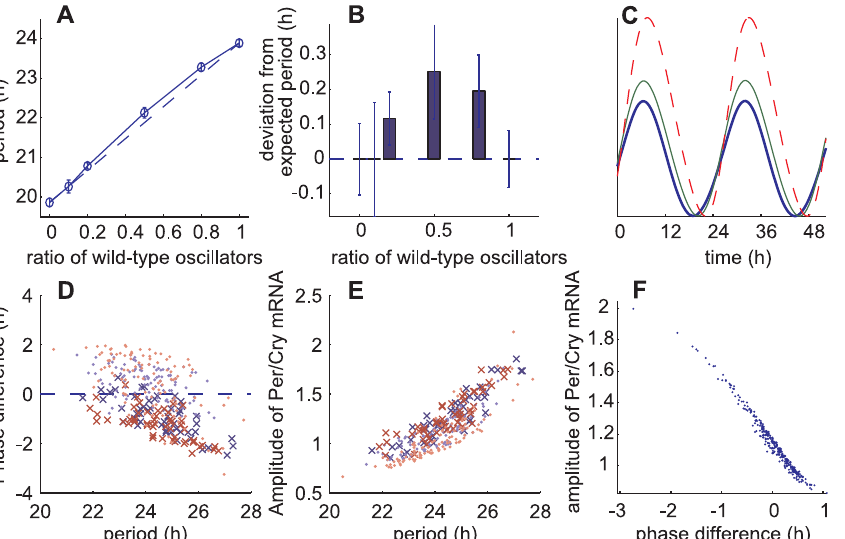
Figure 6. Effect of the Intrinsic Period on Amplitude and Phase (A) Resulting periods of two mixed populations of oscillators, one with a 24 h period and one with 20 h period (type 1 coupling; c 0 ¼ 0.1). The period was calculated with proportions of 24 h period cells of 0.0, 0.1, 0.2, 0.5, 0.8, and 1.0, and results of five runs for each proportion were averaged (total n ¼ 100, [open circles] average period). The dashed line represents the average of the individual oscillators’ periods. (B) Deviation of the resulting population periods shown in (A) from the average of the individual oscillator periods (the error bars are the standard deviations). (C) Three coupled oscillators with different intrinsic periods showing their phase and amplitude relationships: the short period oscillator (thick blue line) is phase-advanced and low amplitude compared with the average period oscillator (green line) and the long period oscillator (dashed red line). (D) Phase difference from the average Per/Cry mRNA concentration with respect to the intrinsic periods, from the simulations shown in Figure 3A and 3B (dark blue 3 , left VL neurons; light blue, left DM neurons; dark red 3 , right VL neurons; light red, right DM neurons). A positive phase difference means phase-advanced compared with the phase of the population. (E) Amplitude with respect to the intrinsic period from the simulations shown in Figure 3A and 3B (color code as in [D]). (F) Amplitude phase relationship for type 1 coupling ( K ¼ 0.9, c 0 ¼ 0.1, number of oscillators n ¼ 100).